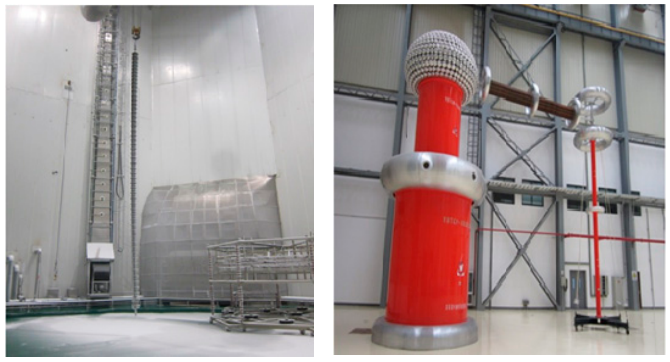
Figure 2. Experimental setup.